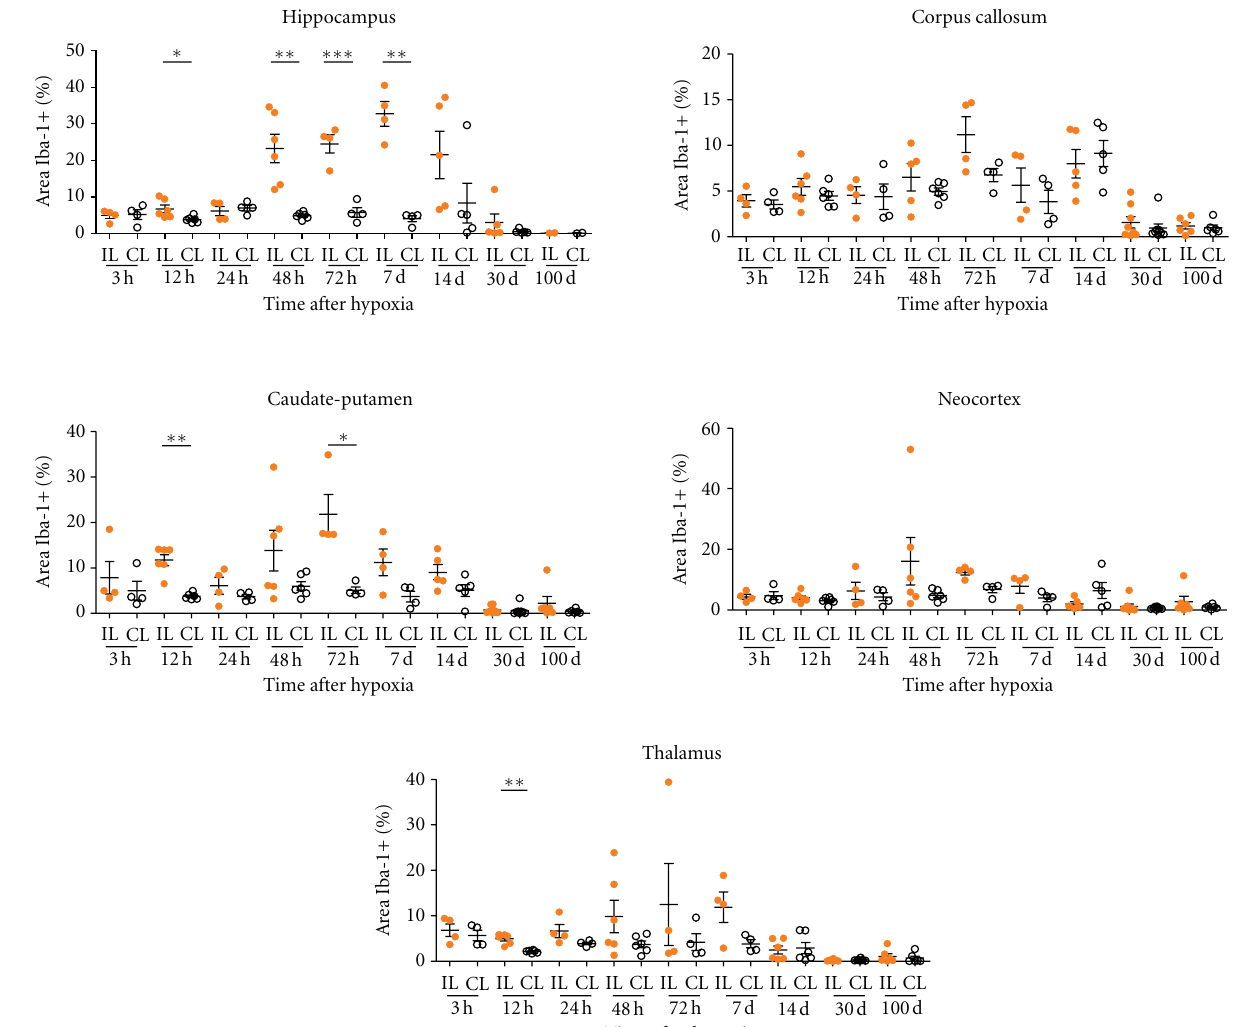
Figure 11: Iba-1+ area on the hippocampus, corpus callosum, caudate-putamen, neocortex, and thalamus is evaluated from 3hrs to 100 days after hypoxia in the ipsilateral (IL) and contralateral (CL) hemispheres. Reactive microglia is shown as the percentage of the Iba-1+ area (see Section 2 for details). The hippocampus is the most a ff ected region by H/I at 12, 48, 72 hrs and 7 days, as can be observed between IL and CL hemisphere. Significant di ff erences on Iba-1+ area are observed at 12 and 72hrs after hypoxia in the caudate-putamen and after 12hrs in the thalamus. Significant di ff erences between IL and CL hemisphere are shown using unpaired t tests, with Welch’s correction if suitable ( ∗ P < 0 . 05, ∗∗ P < 0 . 01, ∗∗∗ P < 0 . 001). Individual data and mean ± S.E.M, are represented to show the dispersion in each